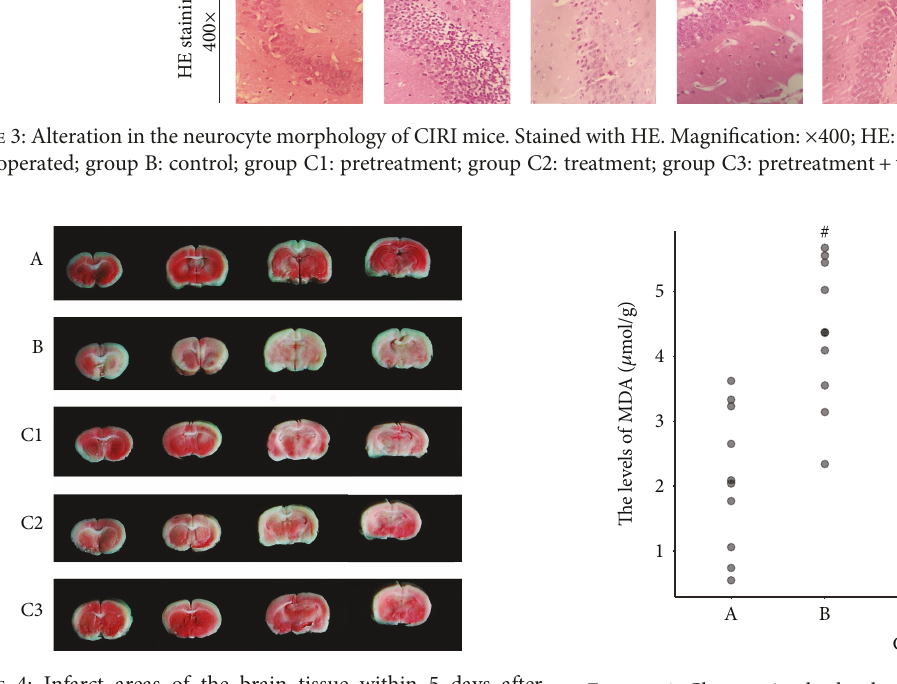
Figure 6: Changes in the levels of MDA in mice cerebral tissue homogenates. # P < 0 01 versus group A; ∗ P < 0 05 , ∗∗ P < 0 01 versus group B. Data are presented as the mean ± standard deviation; n = 10 . MDA: malondialdehyde; SOD: superoxide dismutase; group A: sham-operated; group B: control; group C1: pretreatment; group C2: treatment; group C3: pretreatment + treatment.